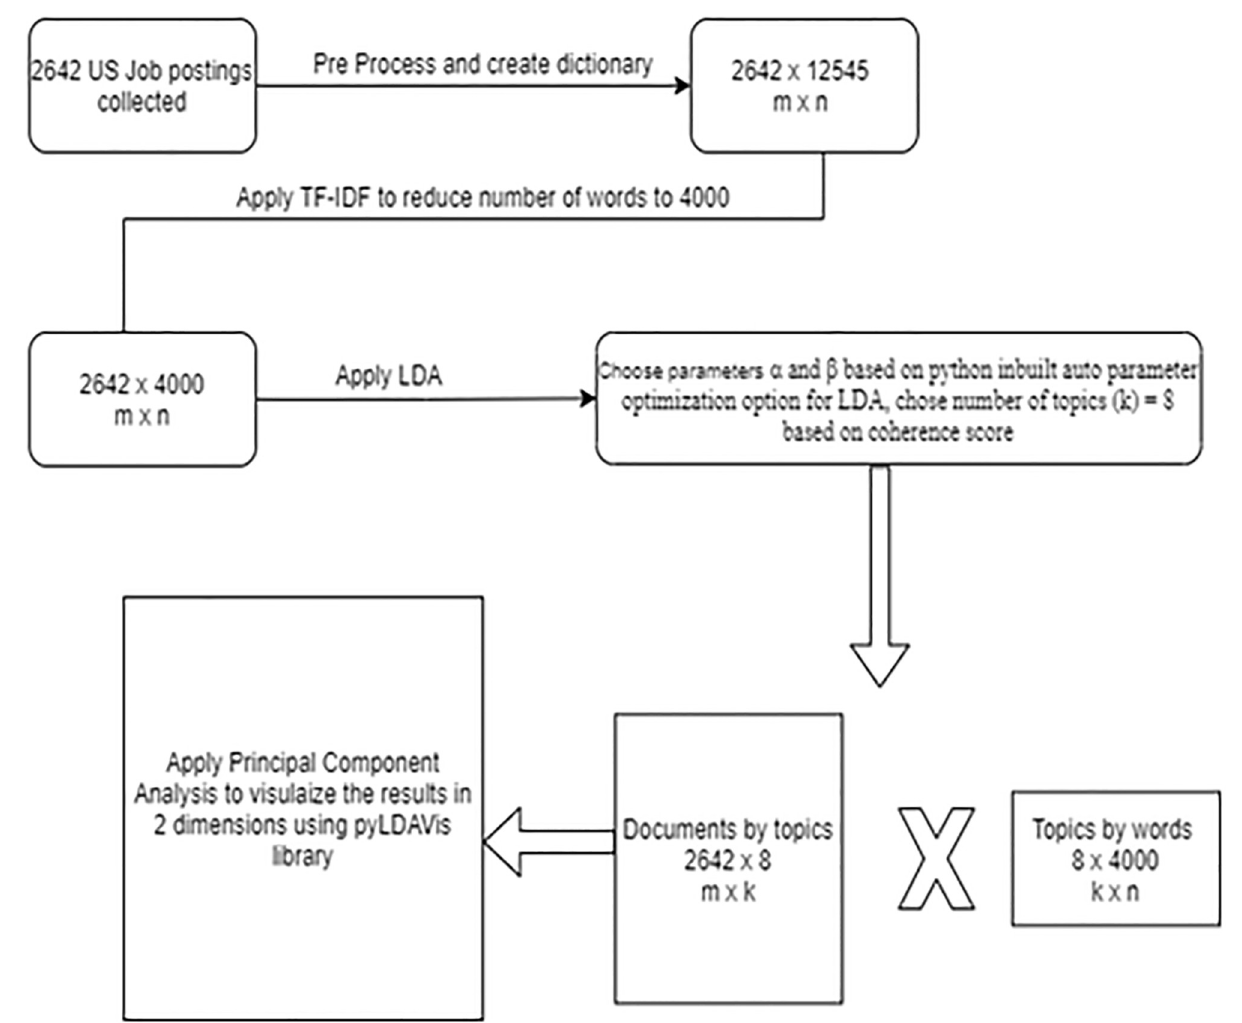
Fig 3. Schematic representation of the methodology used for topic